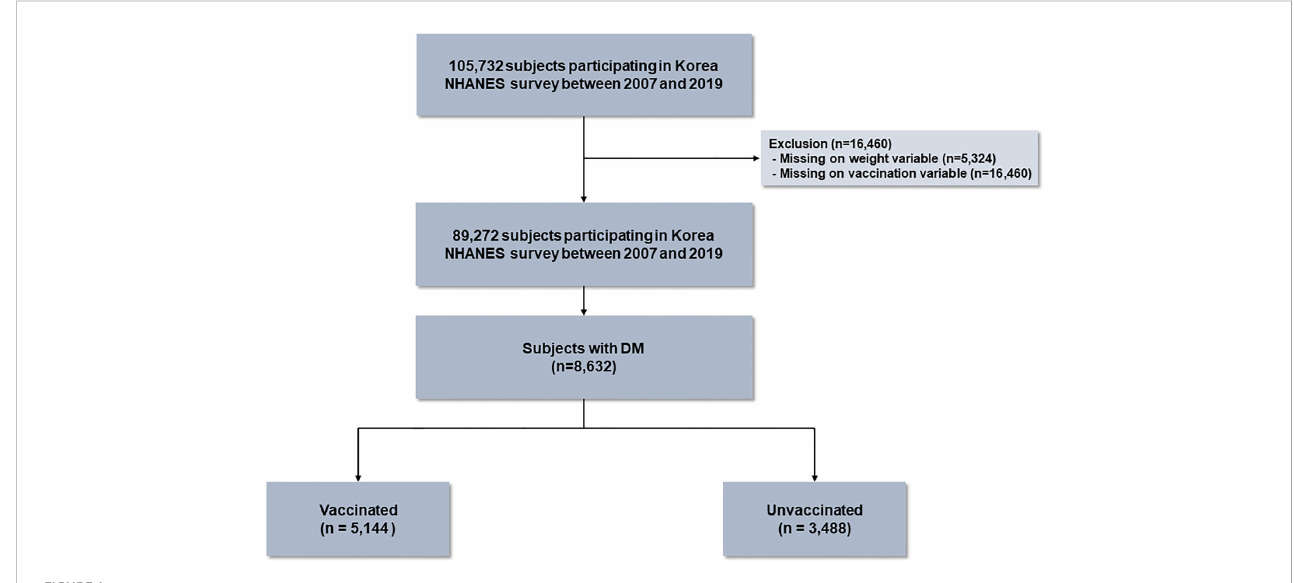
FIGURE 1 Flow chart of the study